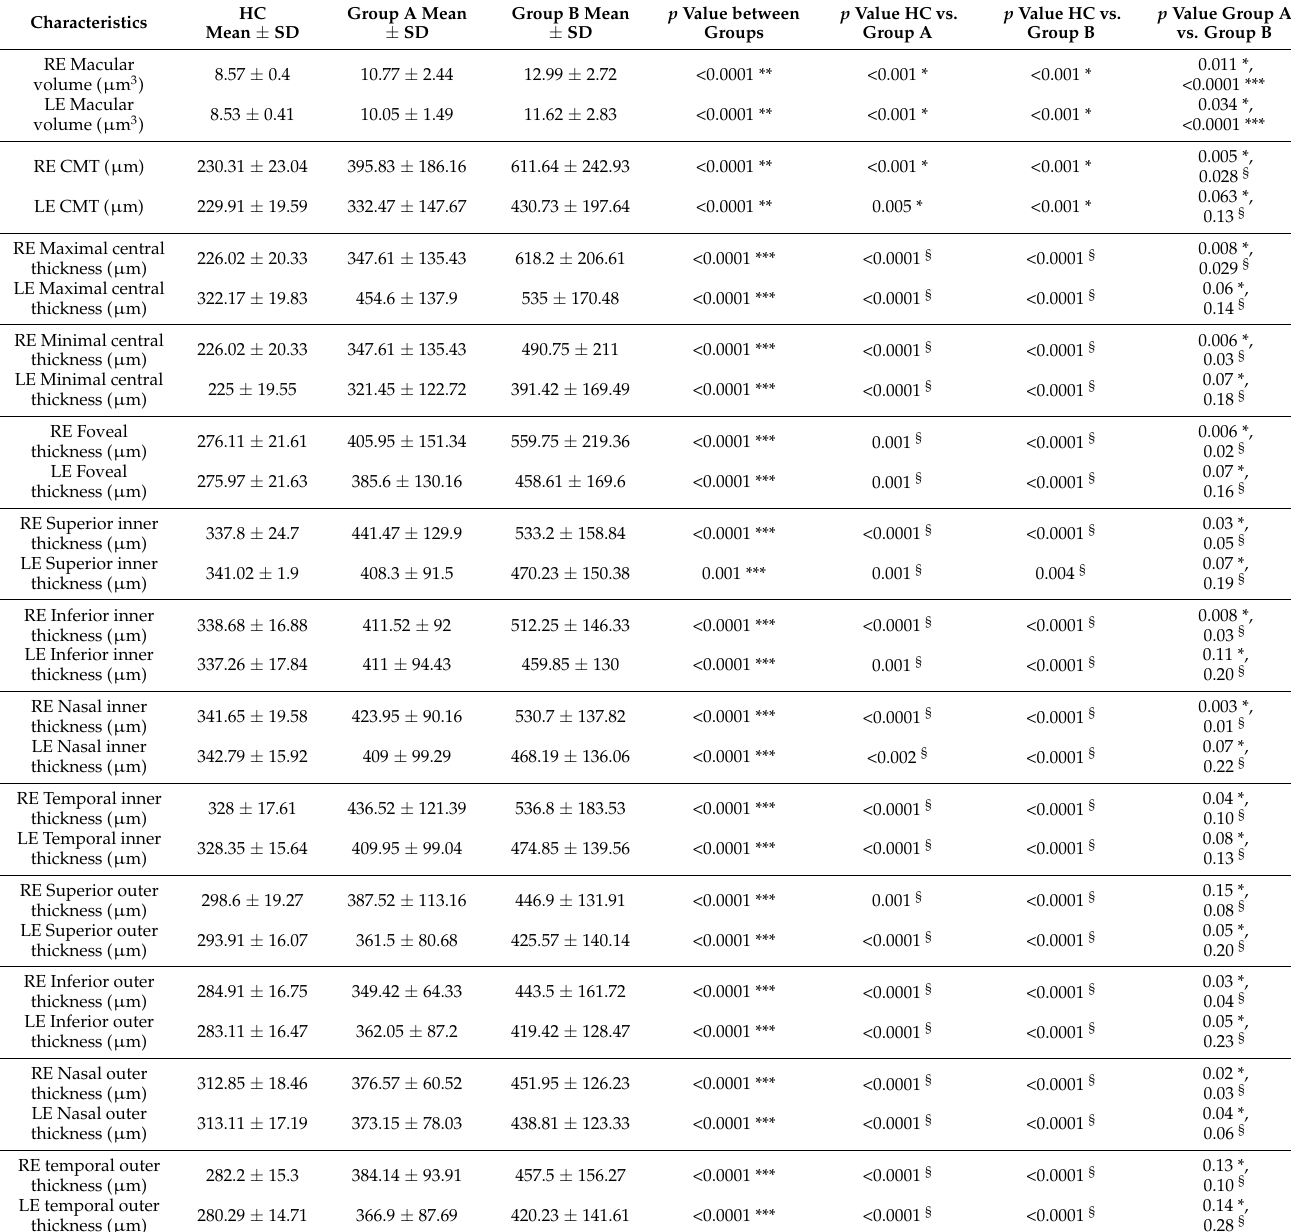
Table 2. Comparison of OCT characteristics between HC, group A, and group